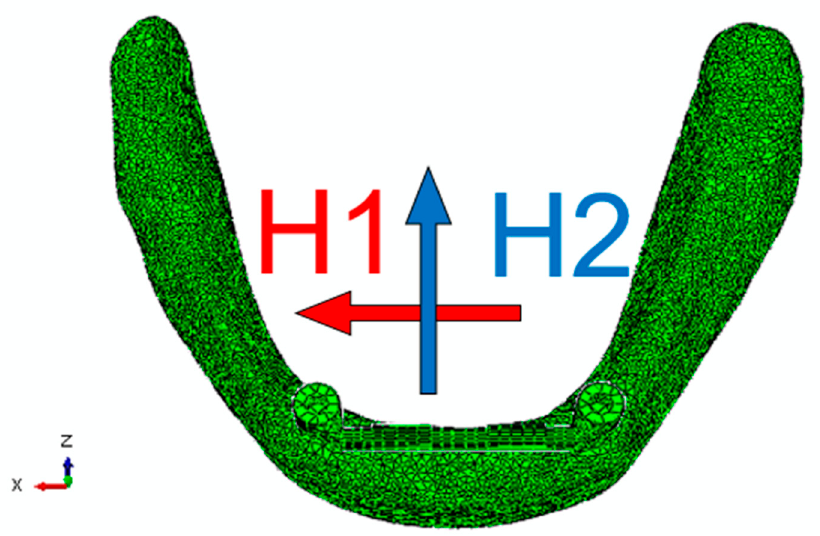
Figure 10. Horizontal forces carried from the prosthesis to the implant system and the dental bar. Table 2. The values of horizontal forces carried from the prosthesis to the implant system and the dental bar.